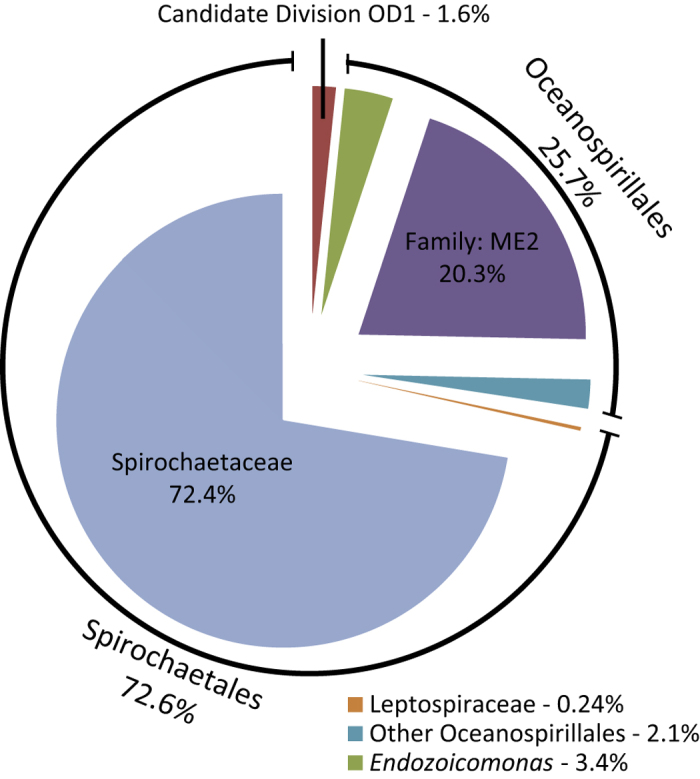
Overview of the composition of the core microbiome associated with Corallium rubrum.The contribution of each taxon to the core microbiome is indicated in percentages (%). All taxa are represented by a single Operational Taxonomic Unit (OTU), except Spirochaetaceae (4 OTUs) and Oceanospirillales from the family ME2 (4 OTUs).